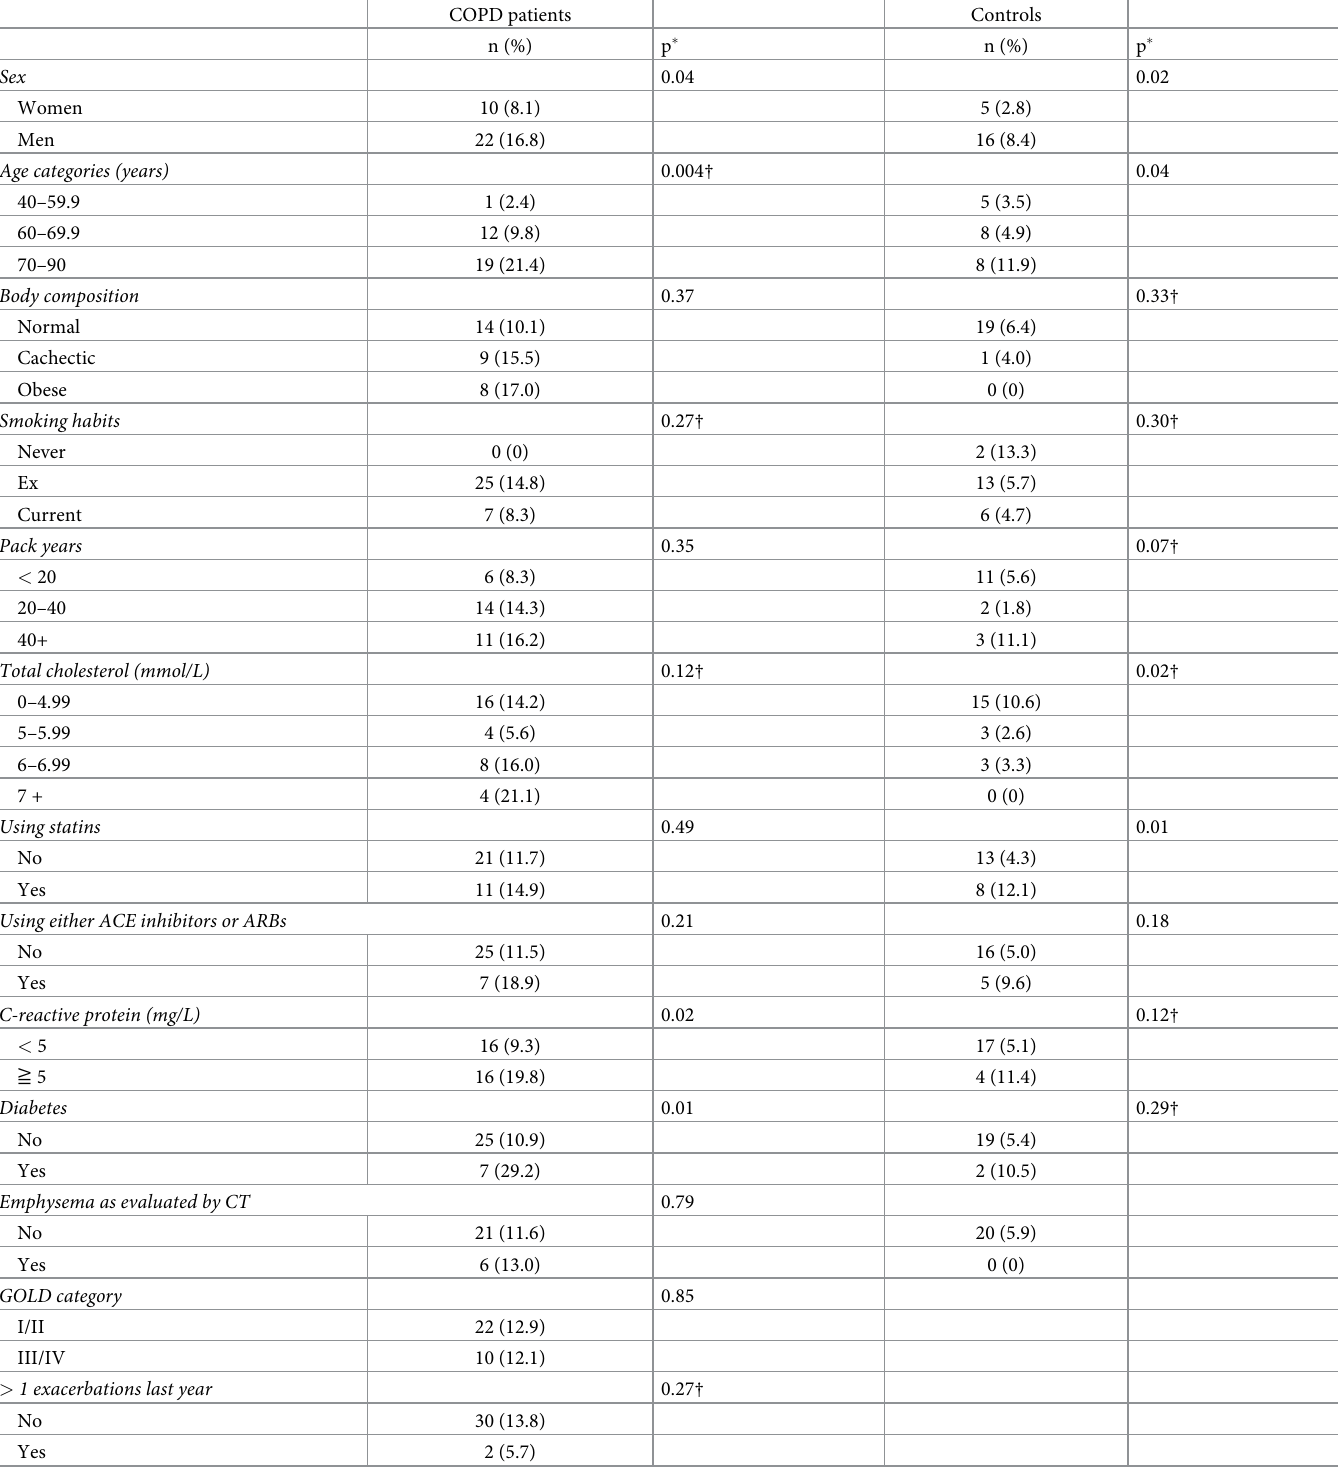
Table 3A. The prevalence of significant ( > 50% lumen reduction) coronary stenosis among 347 COPD patients and 428 non-COPD controls as evaluated from coro- nary CT